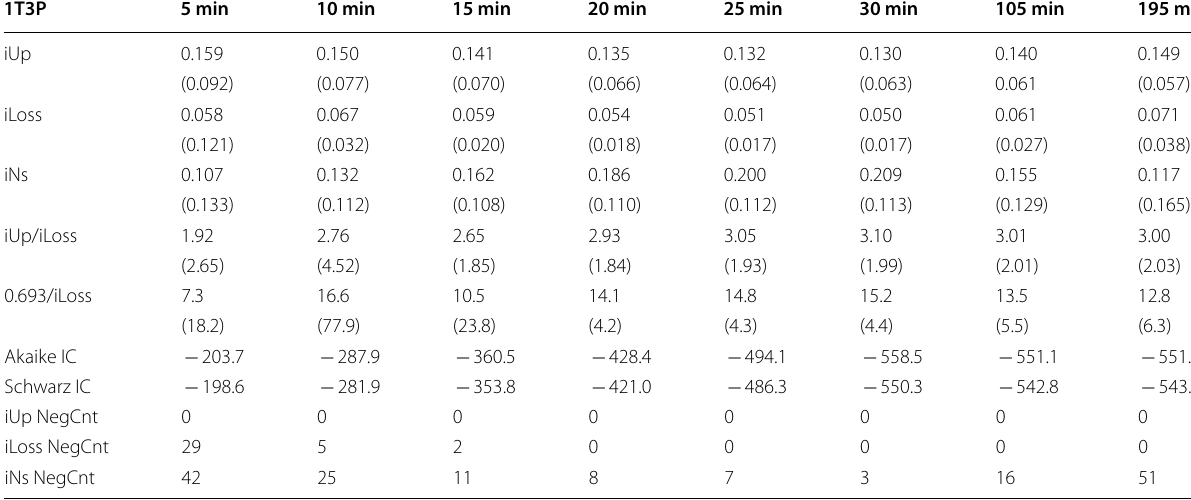
Means (and SDs) of the kinetic indices of 1T3P, Akaike’s information criterion and Schwarz’s information criterion. NegCnt: negative counts that were unfavourable; 0.693/iLoss is the pharmacological half-life